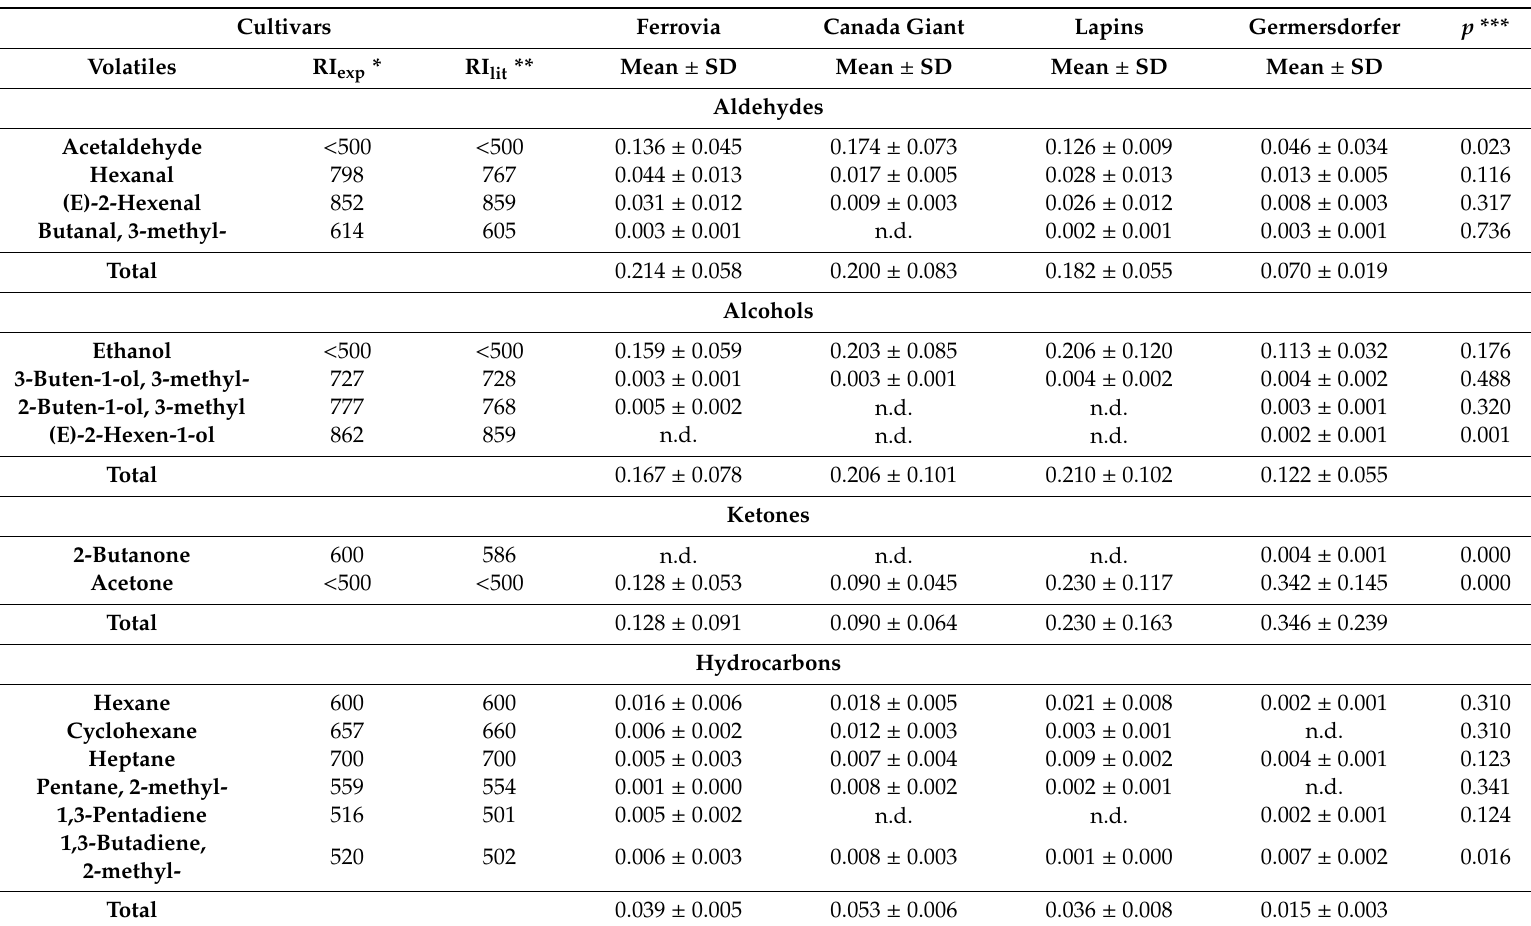
Table 2. Mean values and SD (mg / kg) of volatile compounds of cherry samples